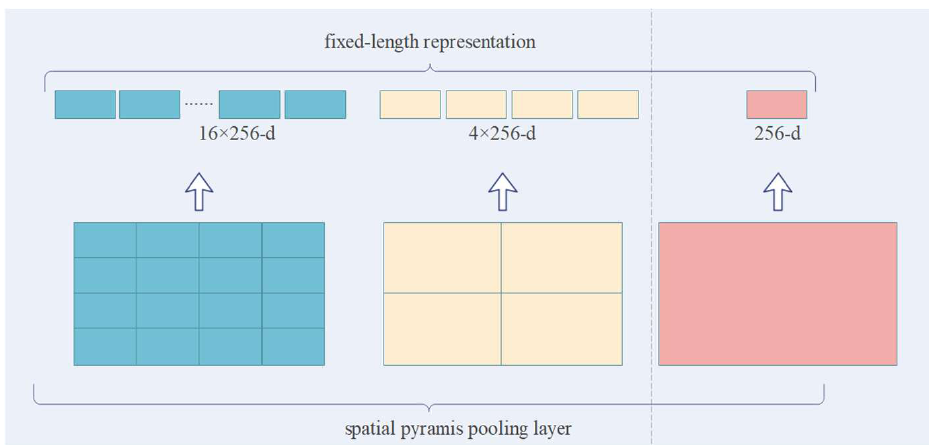
Figure 2. Spatial pyramid pooling